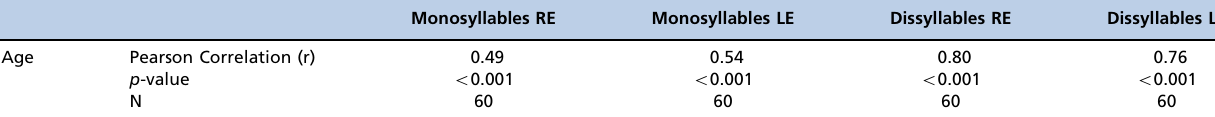
Table 2 - Correlation between age and performance obtained in TCS for modalities, monosyllables and disyllables.